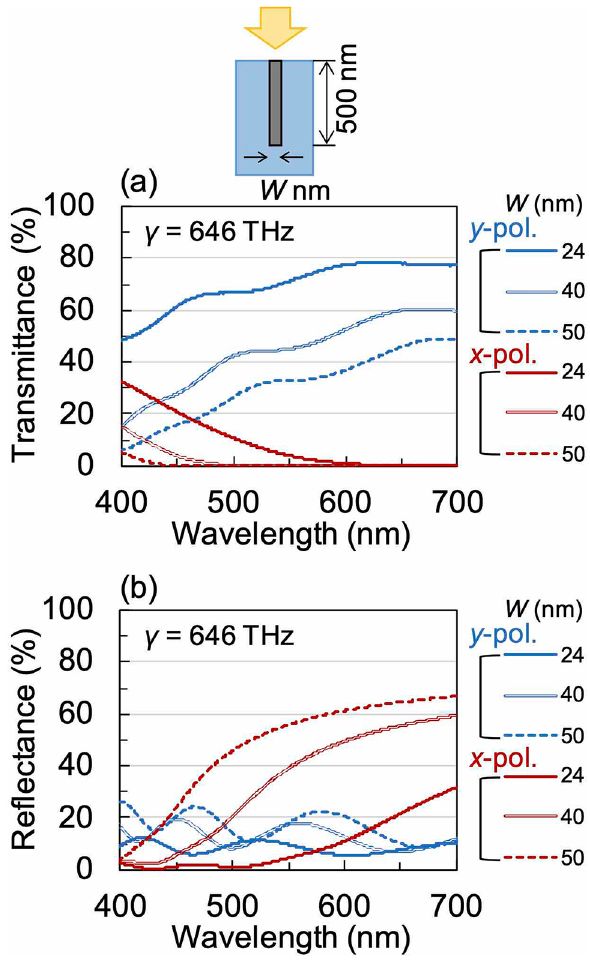
Figure 3. Calculated ( a ) transmittance and ( b ) reflectance spectra of embedded WGP sheet as a function of the width of the wire grid structure W